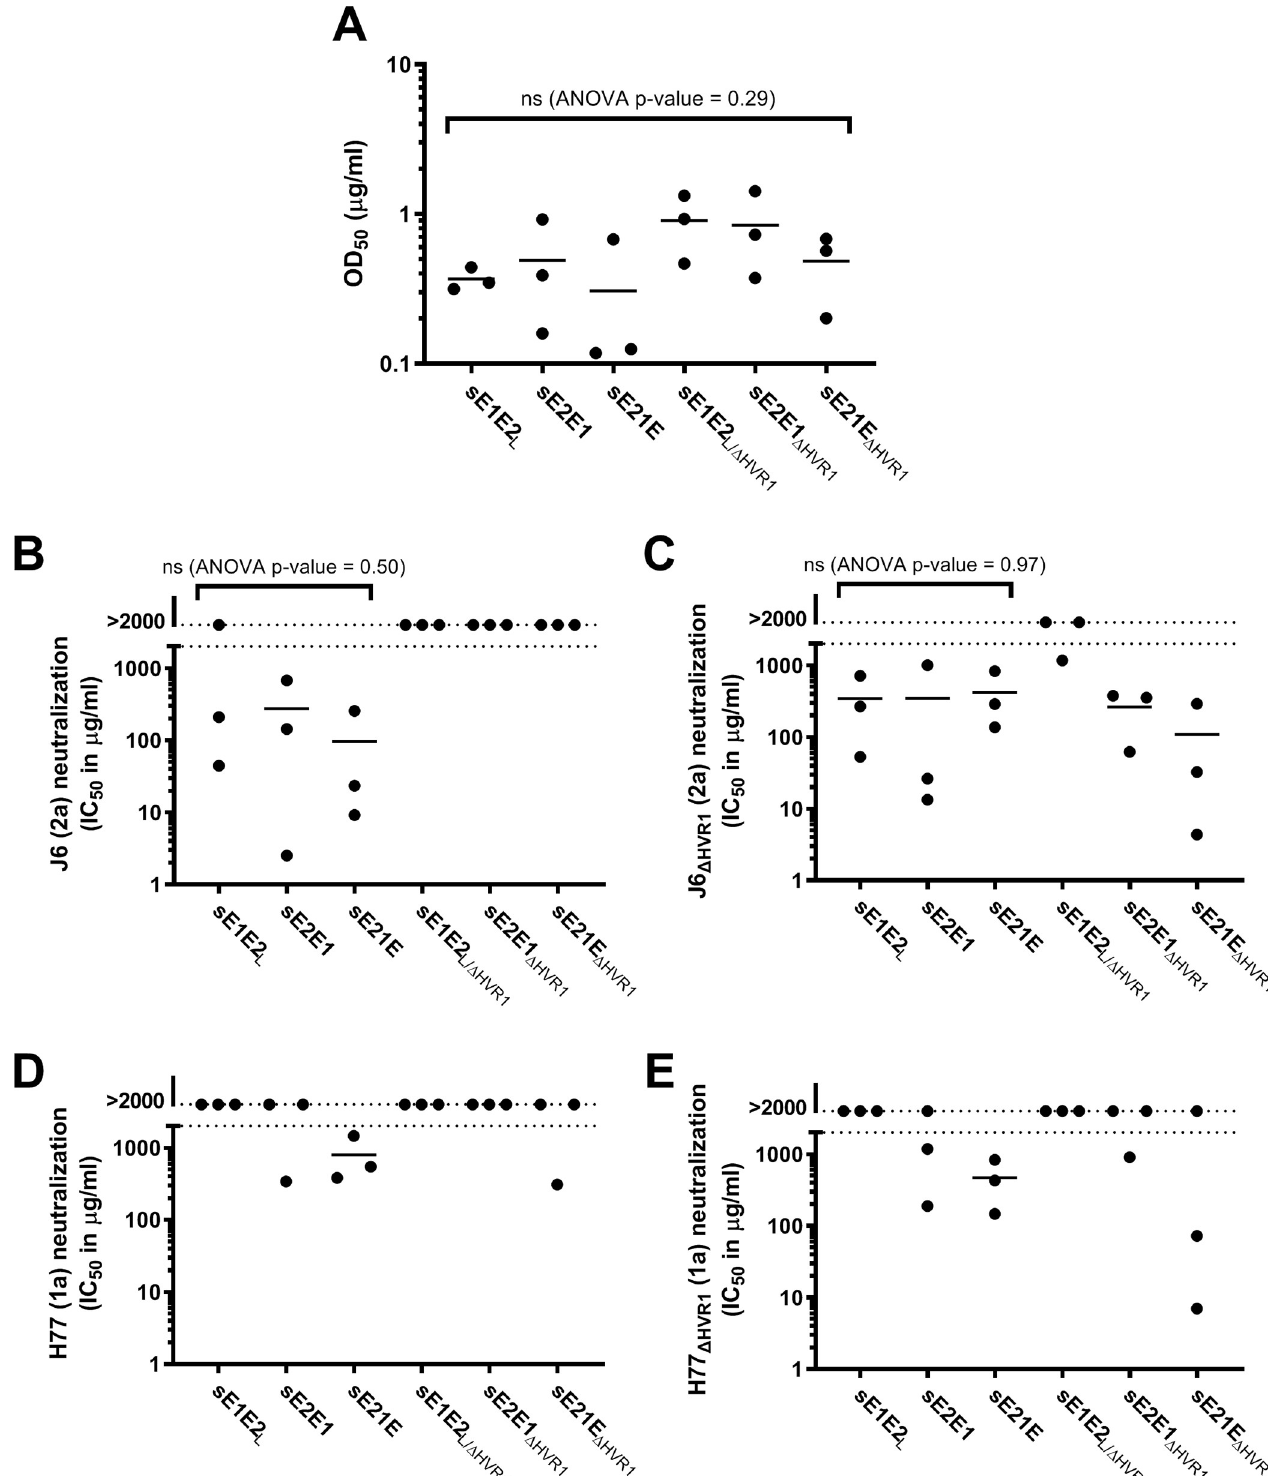
Fig 3. Comparison of immunogenicity and ability to induce HCV NAbs of sE1E2, sE2E1 and sE21E with and without HVR1 in mice. 7–8 week-old BALB/ c mice were immunized with the indicated HIS-tagged antigens in Freund’s incomplete adjuvant and subsequently boosted twice with 3 week intervals. 2 weeks after the second boost the animals were euthanized, and a full bleed was taken and allowed to clot to obtain serum. Total mouse antibodies were purified from